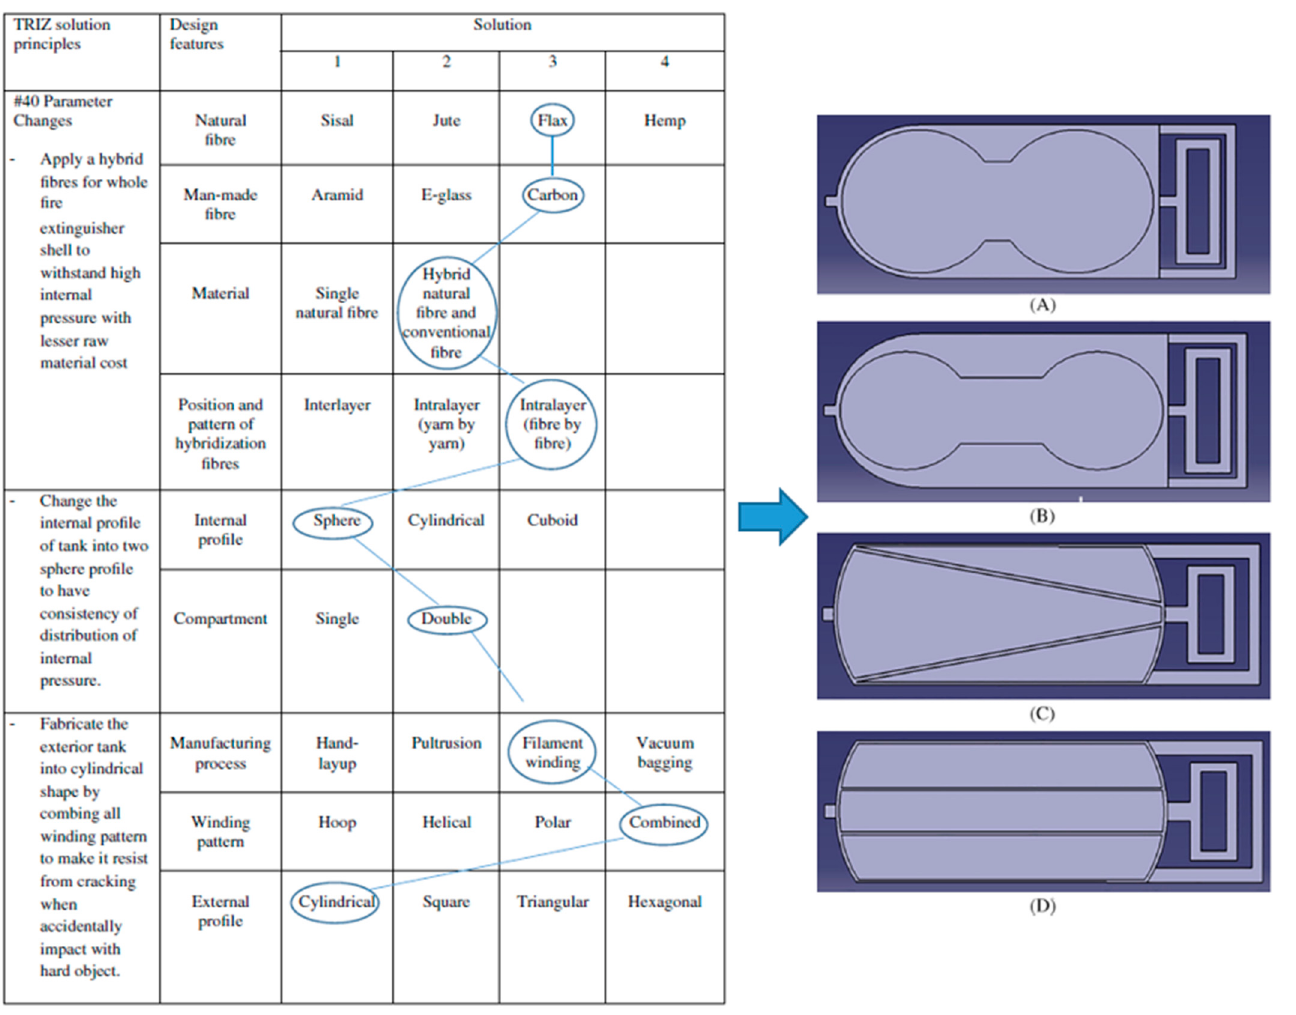
Figure 5. Morphological chart used to elaborate the design characteristics of a fire extinguisher, by Asyraf et al. [104]. ( A )—concept design A, ( B )—concept design B, ( C )—concept design C, ( D )—concept design D